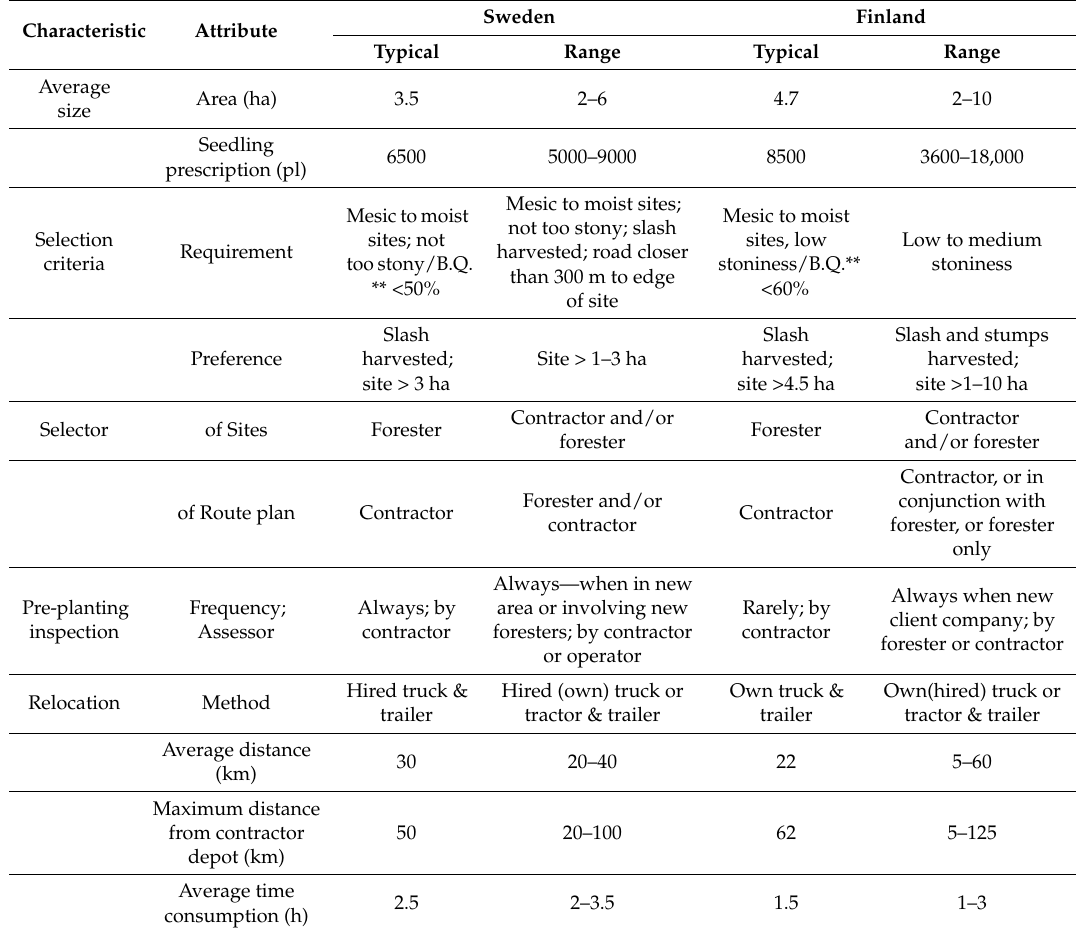
Table 2. Work site characteristics of mechanized tree planting in 2017 in Sweden and Finland (pl = seedlings). Words enclosed by (brackets) in the ‘Range’ columns indicate that the circumstance sometimes occurs.